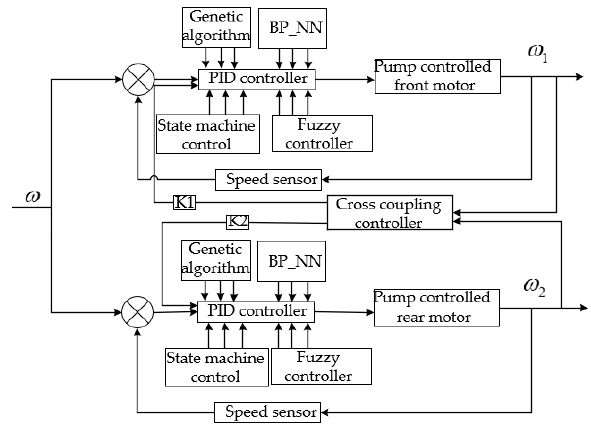
Figure 6. System adaptive tracking control framework.